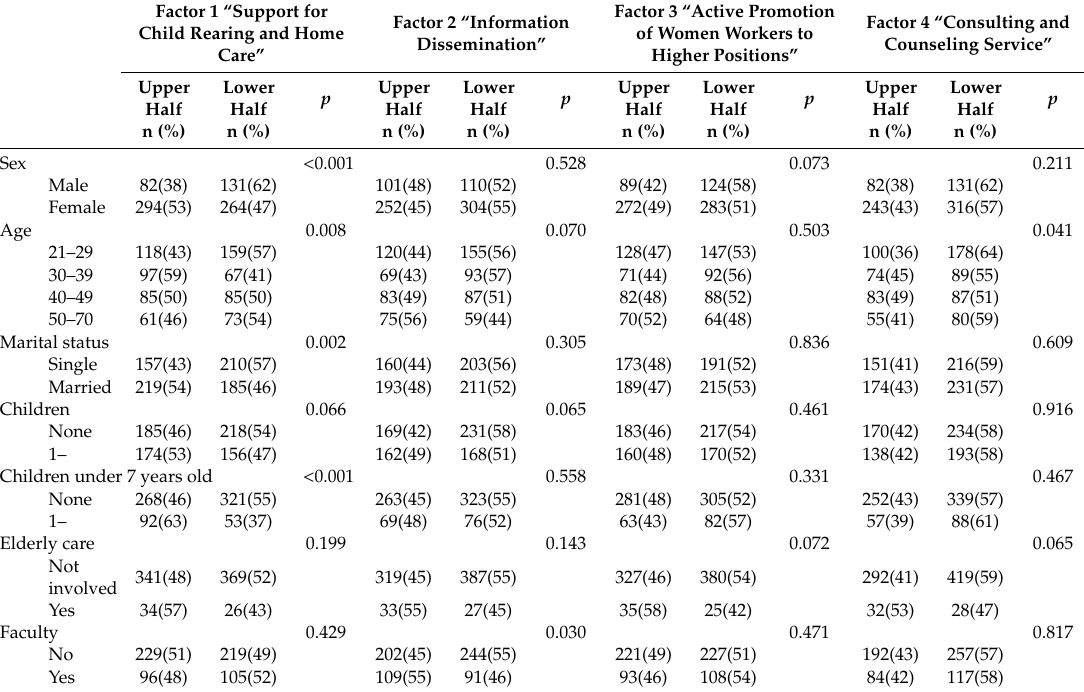
Table 3. Characteristics of subjects related to each